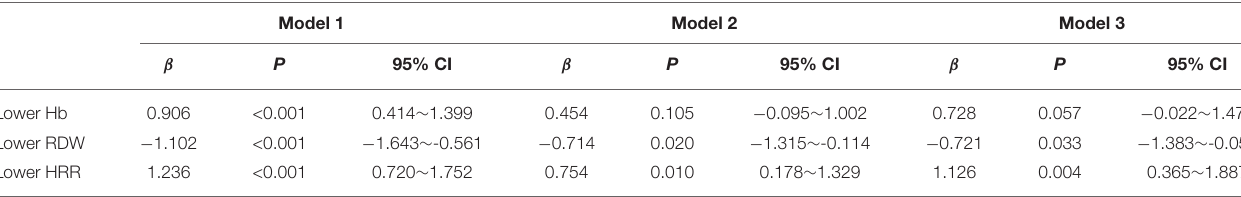
TABLE 5 | Ordered logistic regression analysis of blood parameters and frailty in elderly patients with